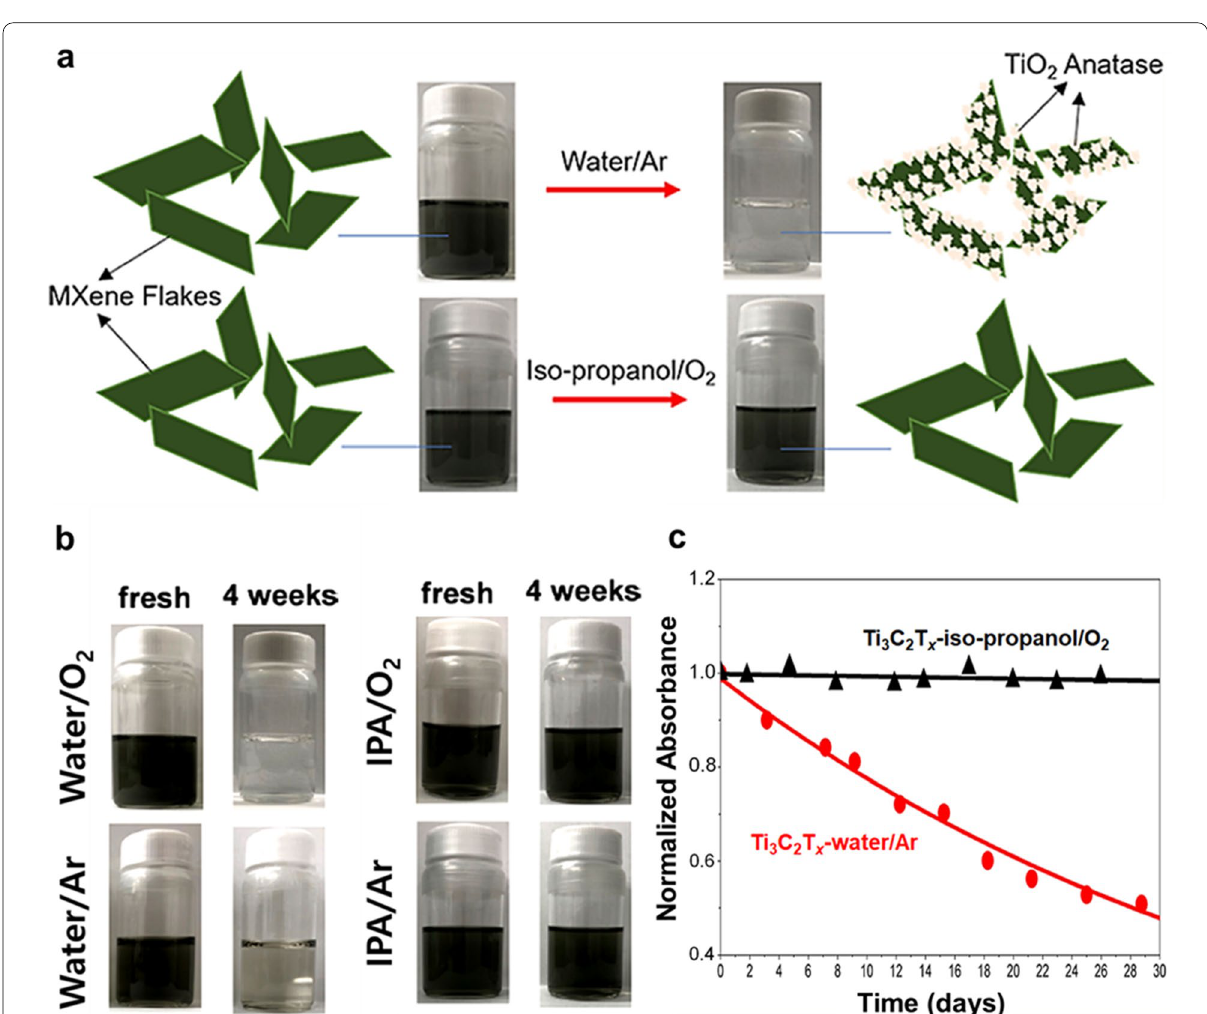
Fig. 10 a Comparative schematic illustration of the oxidation stability of each newly prepared Ti 3 C 2 T x MXene colloidal solution after purging with O 2 or Ar. b Visual appearance of Ti 3 C 2 T x MXene colloidal solutions in different environments over time. c Stability of Ti 3 C 2 T x colloidal solutions in different environments over time. a – c Reproduced with permissions from ref. [38]. Copyright (2019), American Chemical